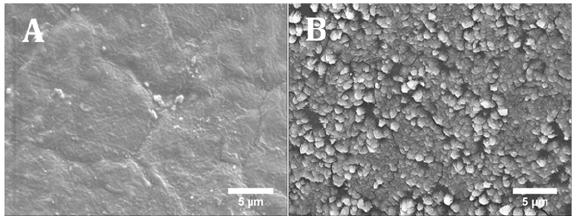
Figure 9. SEM images of PCL/HA 20 wt % surface ( A ) without cells (printed scaffold) and ( B ) with cells after 14 days (cell cultured scaffold).